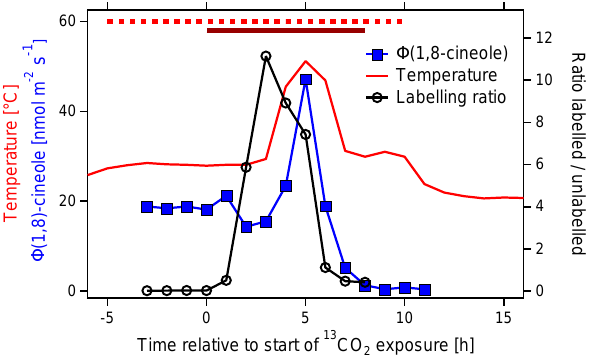
Fig. 4. Emission rates ( 8) of α -pinene from four Scots pine seedlings. Shown are only those data obtained at PPFD=360µmolm − 2 s − 1 . Temperatures were between 12 and 30 ◦ C, and the emission rates were normalized to T = 25 ◦ C using the temperature dependence given in Shao et al.